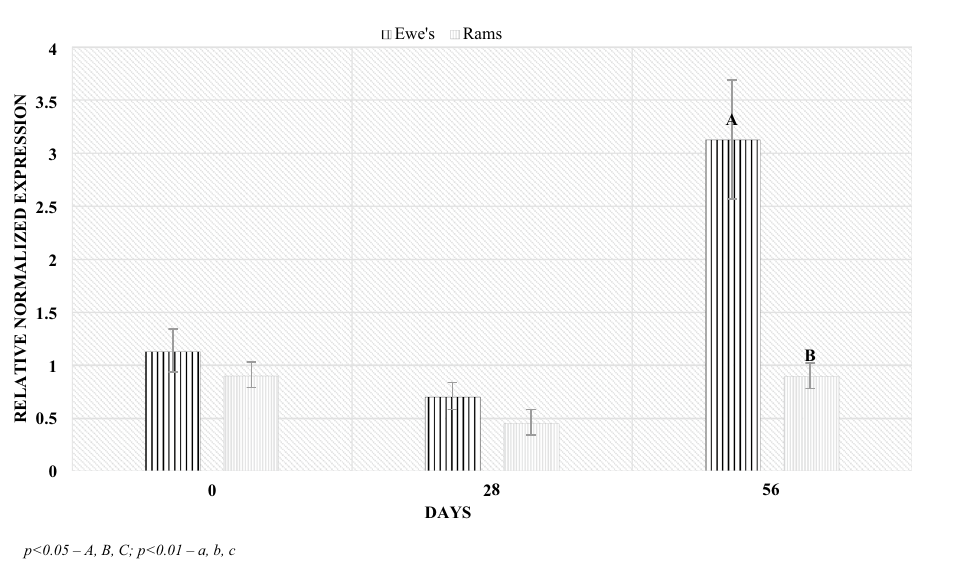
Figure 10. Level of Firmicutes (RNE) depending on sex. p < 0.05—A, B, C; p < 0.01—a, b,